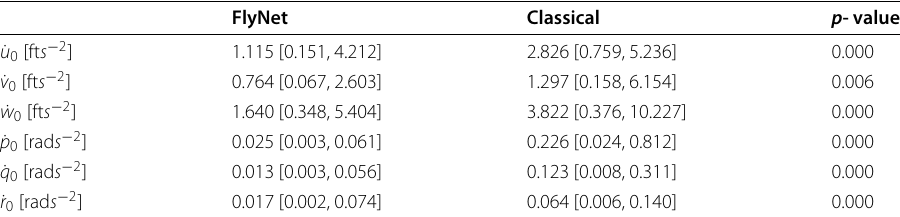
Table4 Average absolute initial trim offsets for test set ( N = 45) with 95% CI and p -value FlyNet